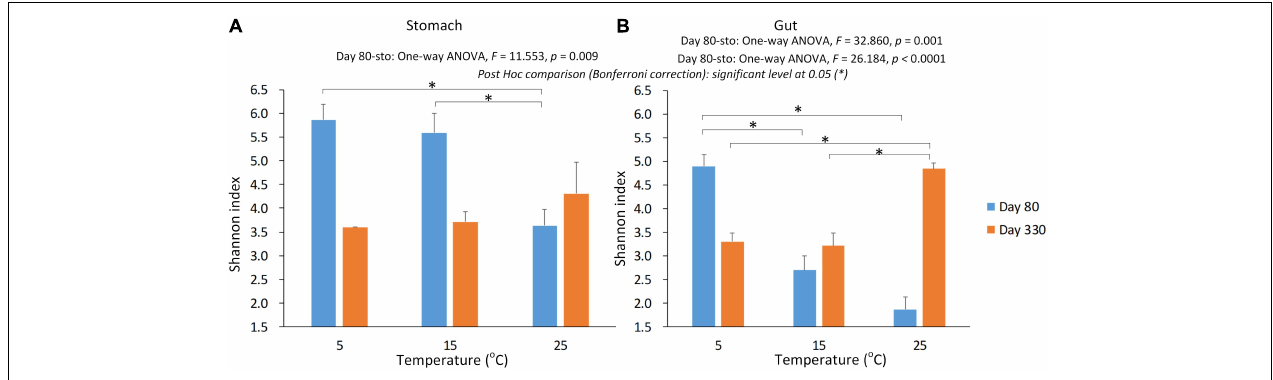
FIGURE 2 | The alpha diversity of the gastrointestinal microbiome under the environmental temperatures. (A) The Shannon in the stomach samples. (B) The Shannon in the gut samples. The one-way ANOVA test was used to test the significant differences among the temperature groups within the same sample type at each sampling time. If significant, the post hoc test [by Bonferroni correction: significant level at 0.05 ( ∗ )] was used to pairwise comparisons among the temperature groups within the same sample type. Due to only one stomach sample at 5-degree group was successfully gained the 16s data on day 330, we didn’t include this sample in the statistical analysis.